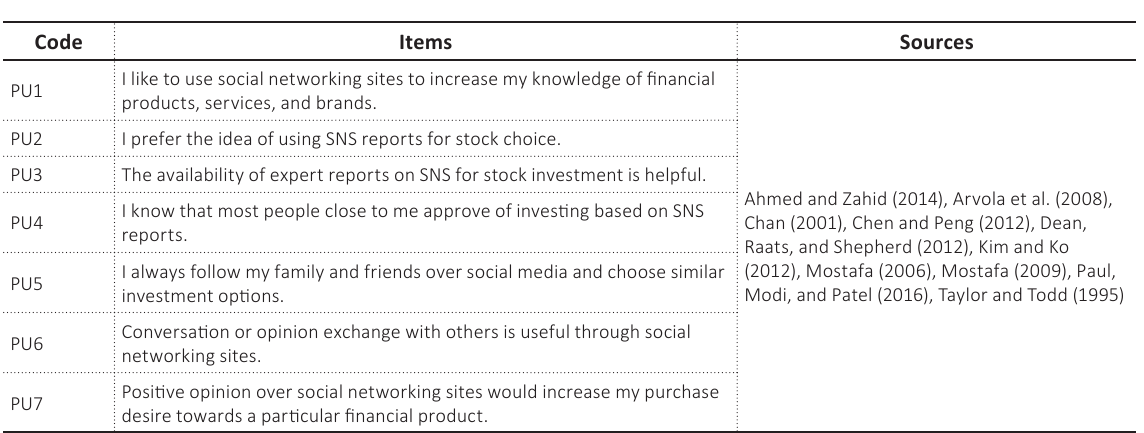
Table 2. Measurement